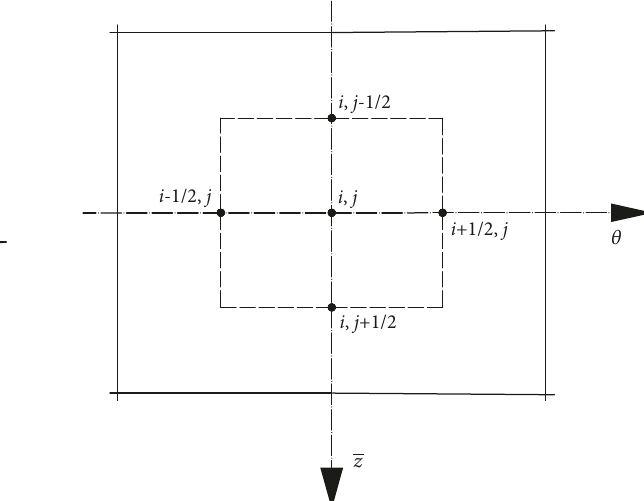
Figure4:Theschematicdiagramforcalculationofoilfilmthickness of sliding bearing.